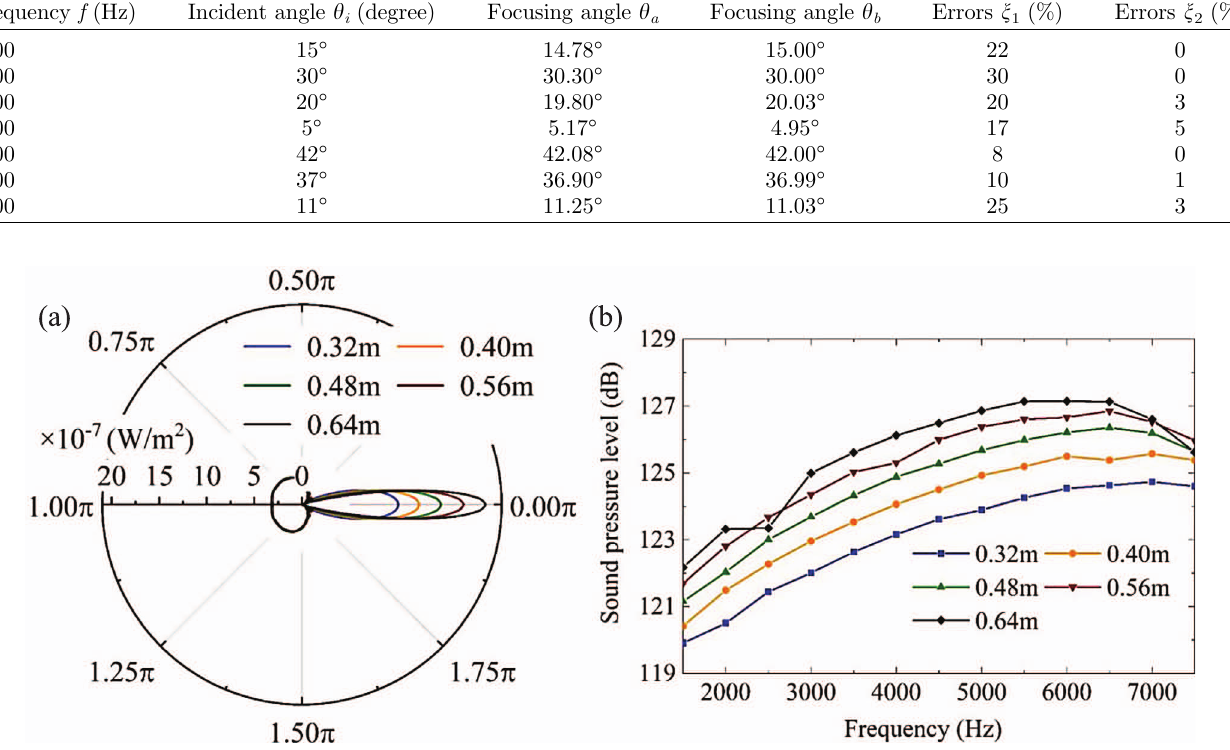
Figure 6. (a) Wave intensity of the acoustic wave focusing with different radii R of the Luneburg lens. (b) Sound pressure level as a function of frequency when the radius R is from 0.32 m to 0.64